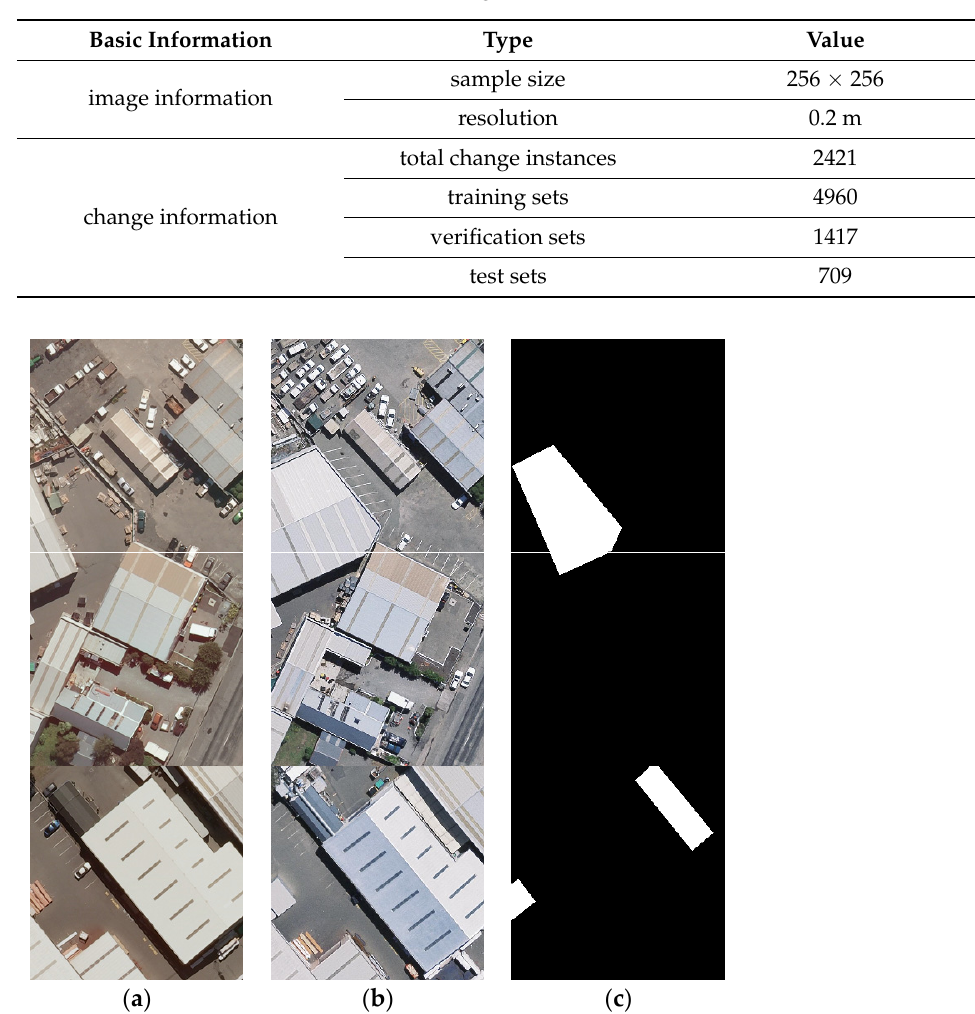
Table 1. Basic information of the WHU building dataset.